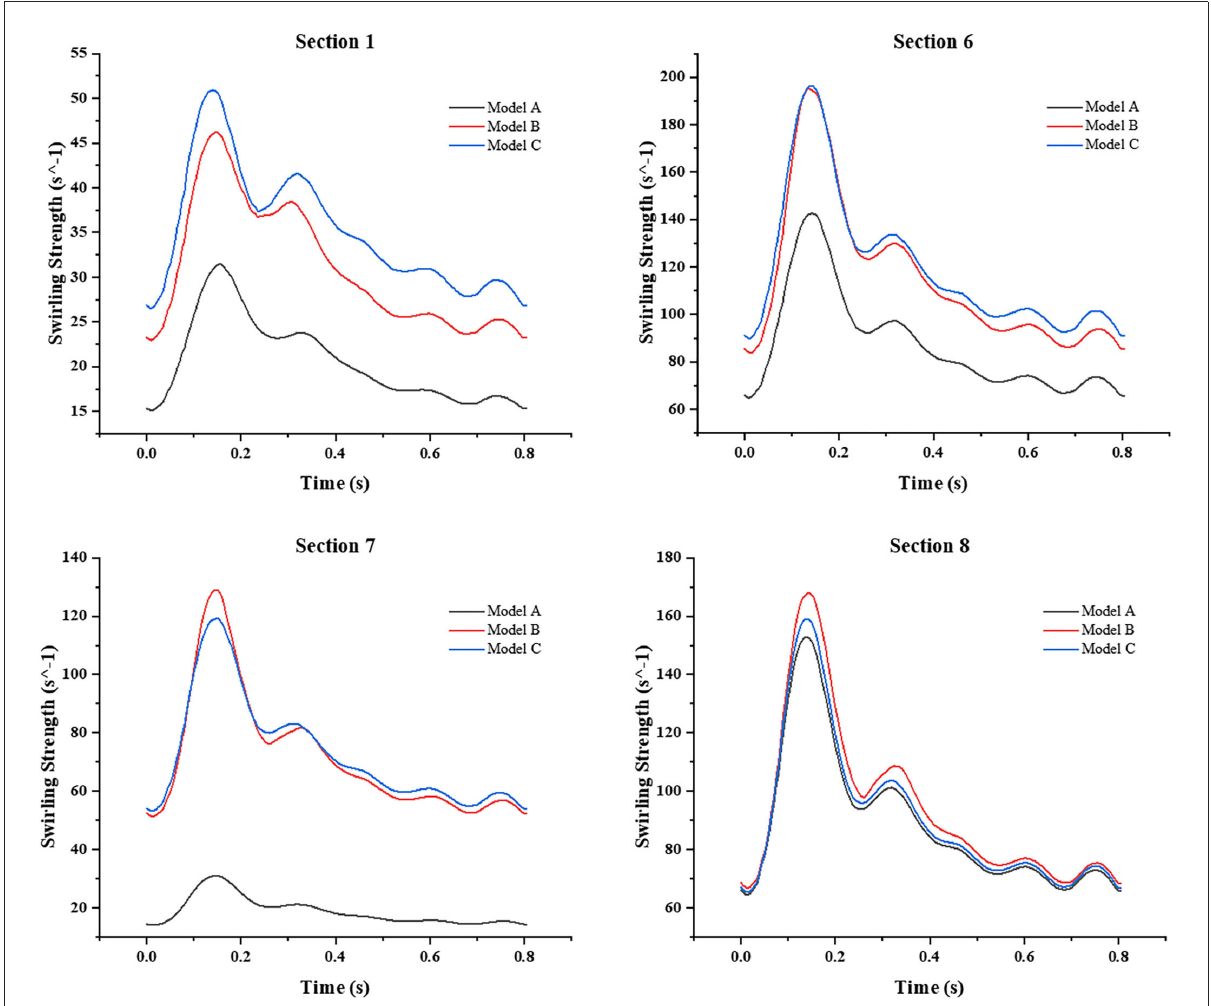
FIGURE11 The change in area-averaged swirling strength in cross sections over time in one